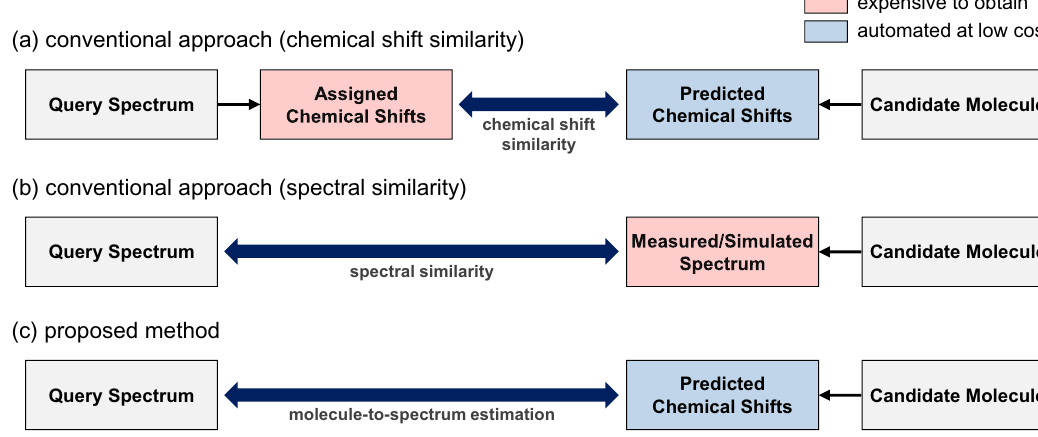
Figure 1. Comparison of conventional approaches and proposed method.